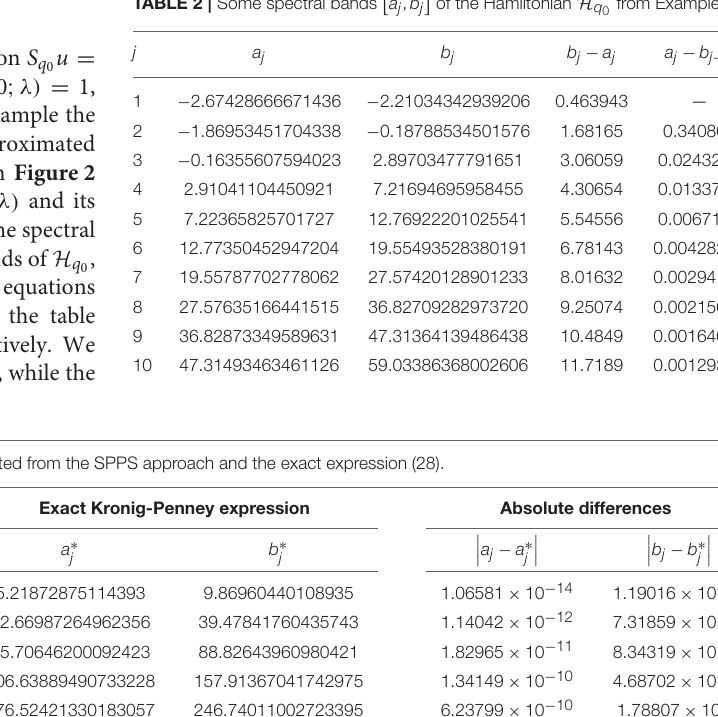
D (λ) from Example 2. e